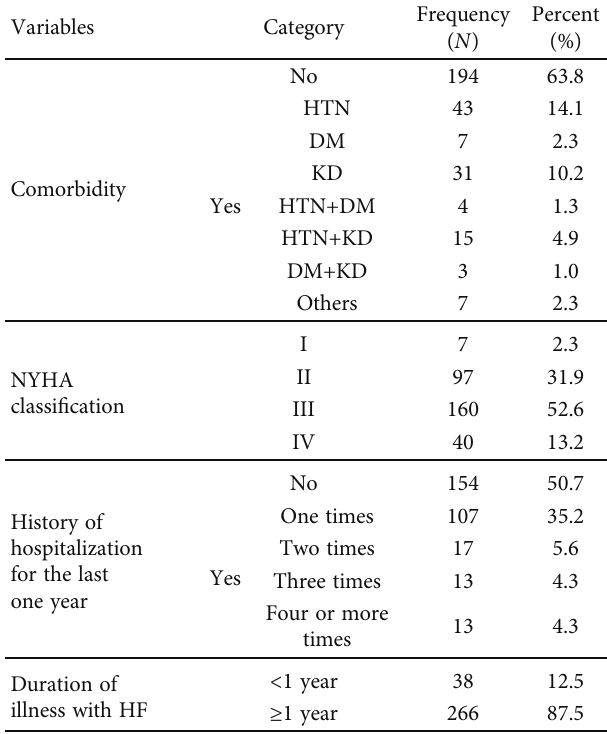
Table 1: Sociodemographic characteristics of participants in West Gojjam Zone public hospitals, Northwest, Ethiopia, 2021.